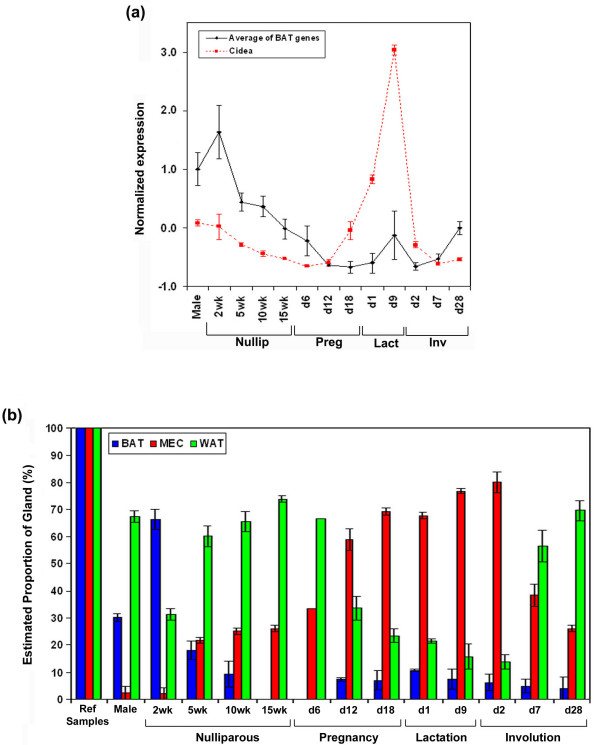
Expression profiles of BAT-specific genes and estimated changes in cell compartment sizes during mammary gland development. (a) Normalized expression profile of Cidea across mammary gland development stages showing marked deviation during late pregnancy and lactation from the average profile of 10 BAT-specific genes listed in Table 1. Mean expression (±SEM) is shown at each development stage, including nulliparity (Nullip), pregnancy (Preg), lactation (Lact), and involution (Inv). (b) Calculated proportions of brown adipose tissue (BAT), white adipose tissue (WAT), and mammary epithelial cell (MEC) compartments in pure reference samples and mammary tissues at the indicated mammary developmental time points (mean ± SEM).